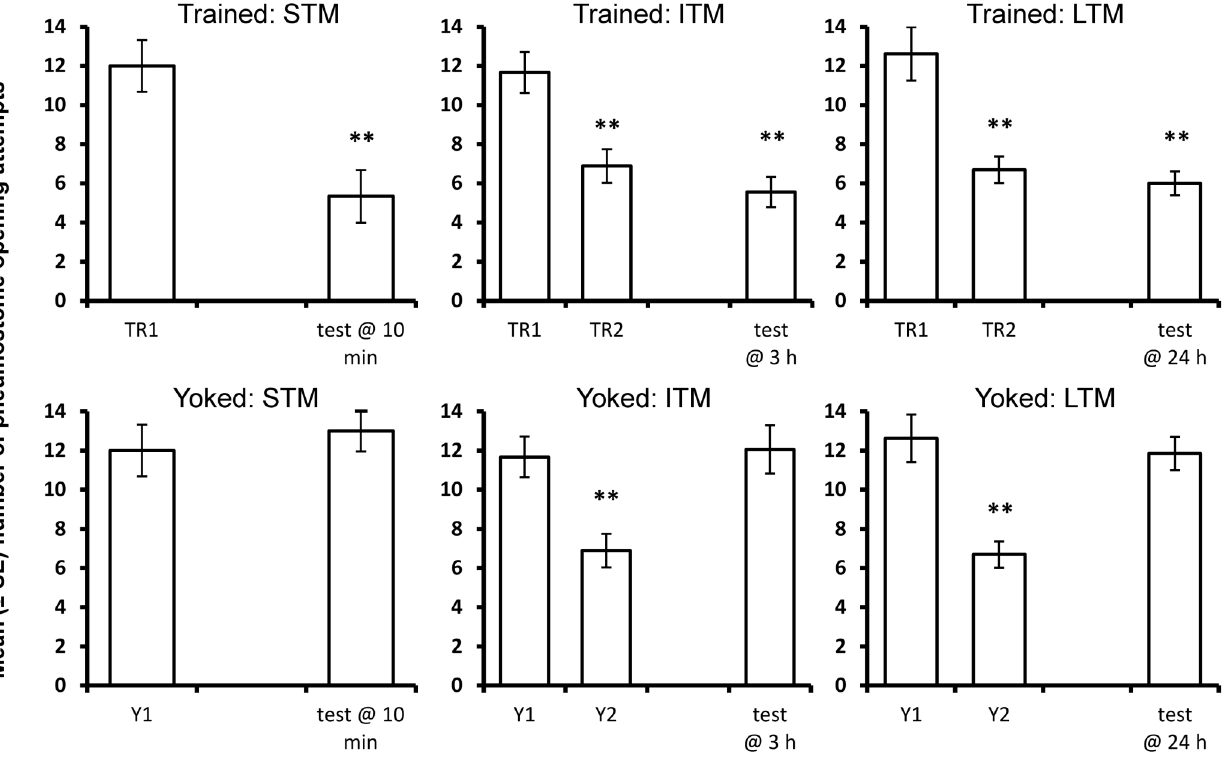
Figure 2. Comparison between operantly trained and yoked training procedures in control conditions. Lymnaea demonstrated memory at all three time periods following operant conditioning, but breathing attempts during the memory test did not differ significantly from the number of stimuli during Y1 following yoked-control training (STM: N=12; ITM: N=18; LTM: N=13). ** = significantly different from Y1 or TR1 (P , 0.01, paired t-test).